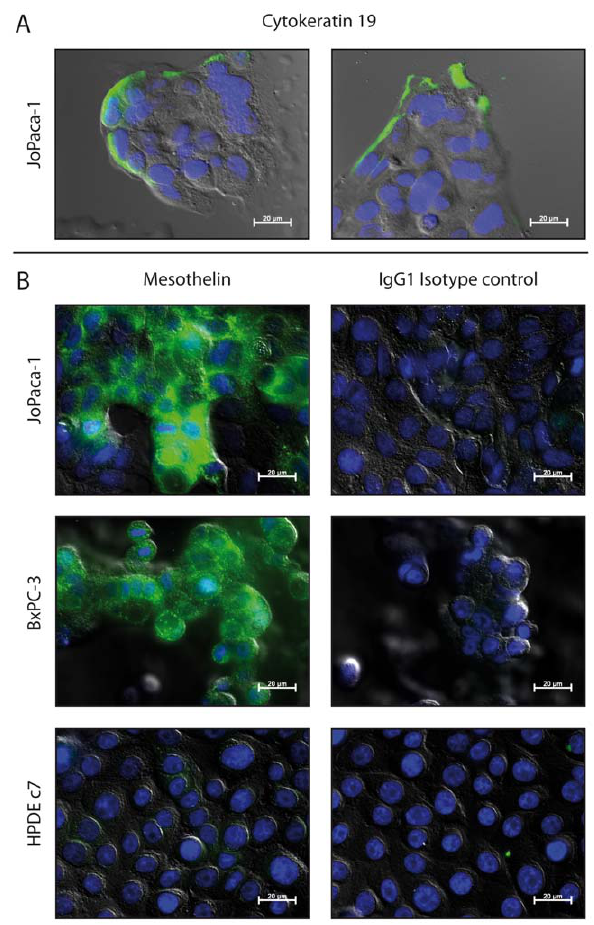
Figure 8. Immunofluorescence of cytokeratin 19 and the tumour marker mesothelin in cell culture. Phase contrast images are presented that show mesothelin and cytokeratin 19 as detected in fixed JoPaca-1, BxPC-3 and HPDE c7 cells. Both proteins were marked with primary and FITC-conjugated secondary antibody (green). Nuclei were stained with DAPI (blue). Isotype controls were negative. A. Cytokeratin 19 is expressed at the growing front of JoPaca-1 cells. B. JoPaca-1 and the established cell line BxPC-3 both express mesothelin while the normal pancreatic ductal cell line HPDE c7 does not.